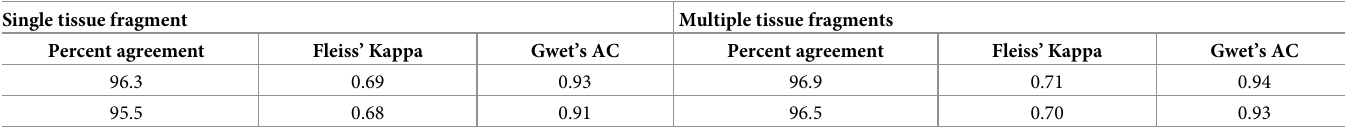
Table 6. Overall concordance of histologic parameters based on number of tissue fragments assessed per image. Single tissue